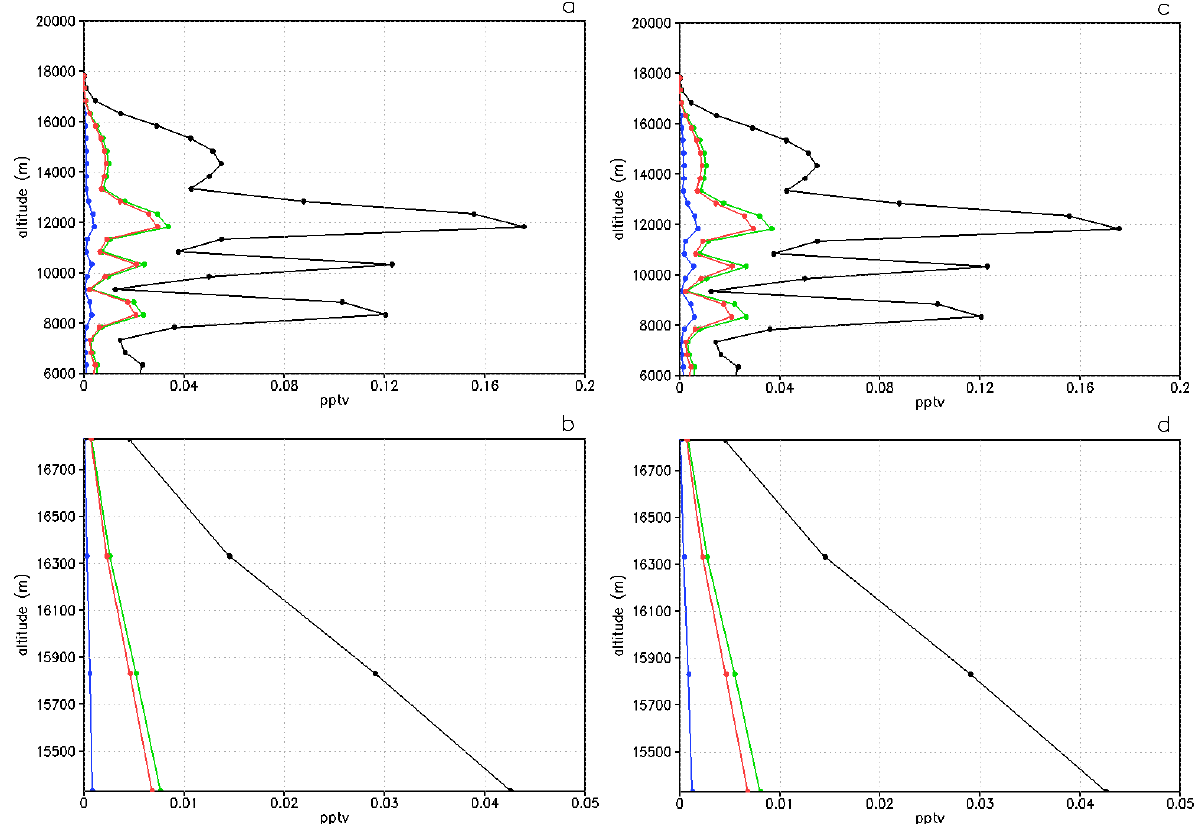
Figure 15: same as figure 13 for the PERT2 simulation.